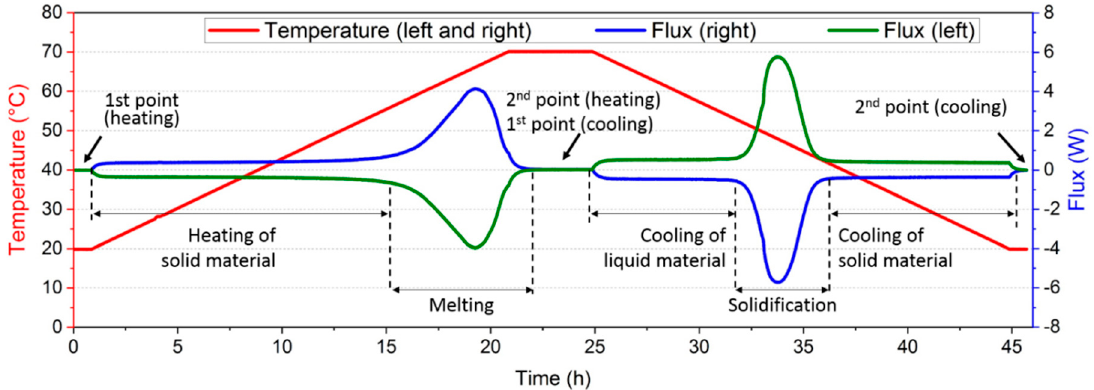
Figure 2. Description of a full thermal cycle.